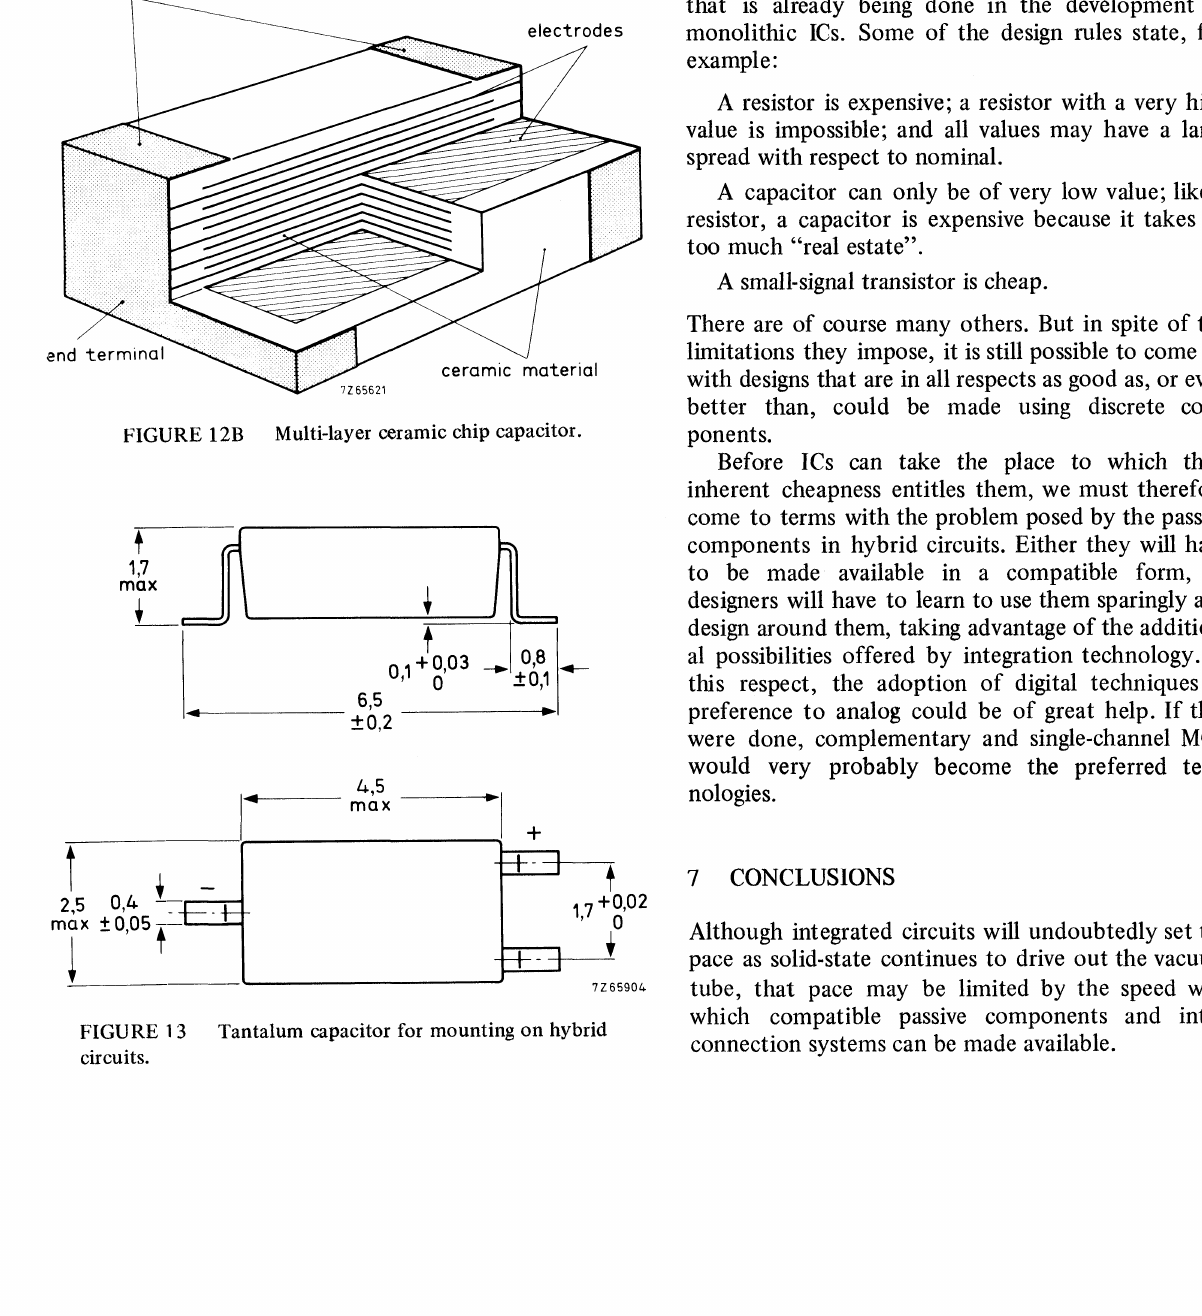
FIGURE 13 Tantalum capacitor for mounting on hybrid